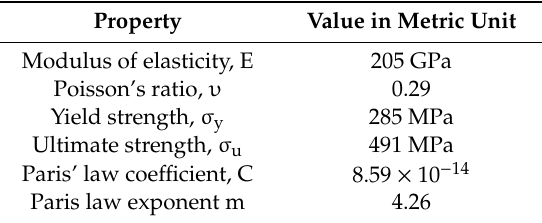
Figure 2. Geometrical description of the modified compact tension specimen (MCTS) (dimensions in mm). Table 1. Material properties of SAE 1020 carbon steel.